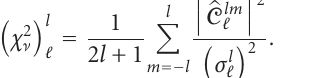
Figure 6: Probability density functions for x (blue, dashed line), y (red, dot-dashed line), and z (solid line). The shaded area gives the probability of x being smaller than x 0 (dashed vertical line). See the text for more